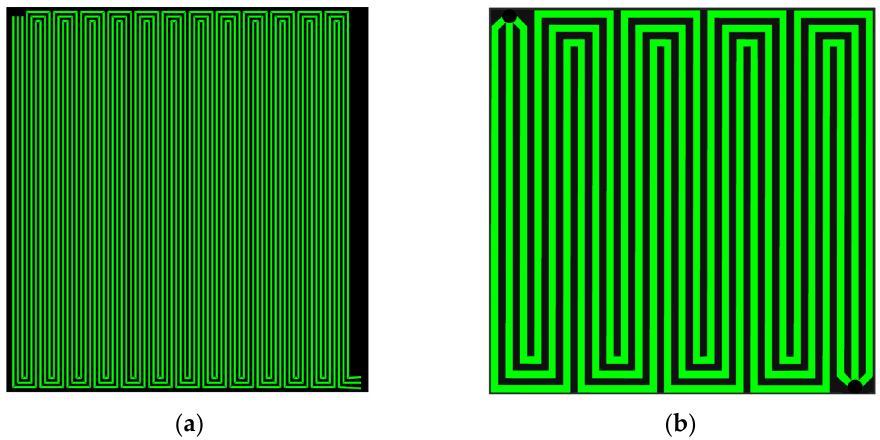
Figure 12. Area where the channels contacted the MEA: ( a ) BP with W0.3, R0.3; ( b ) BP with W0.94, R0.94.